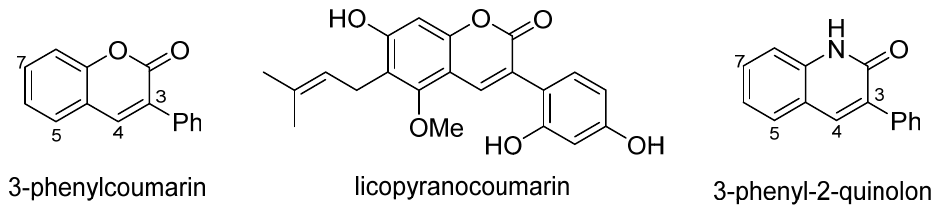
Figure 2. Structural analogy between 3-phenylcoumarin and 3-phenyl-2-quinolone and the struc- ture of a natural